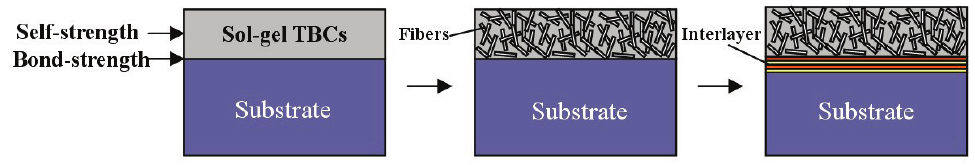
Figure 8. Schematic illustration of different types of sol-gel